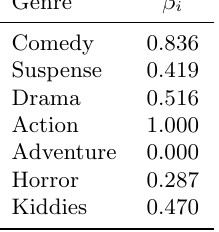
Table 2: Movie genre scores for 2004.